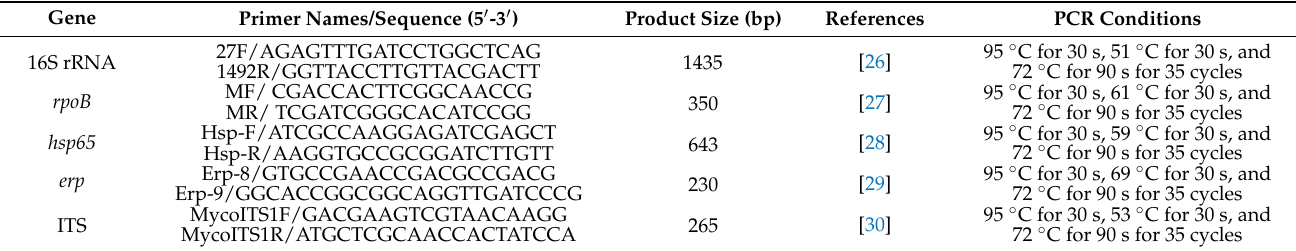
Table 1. Primers used in this